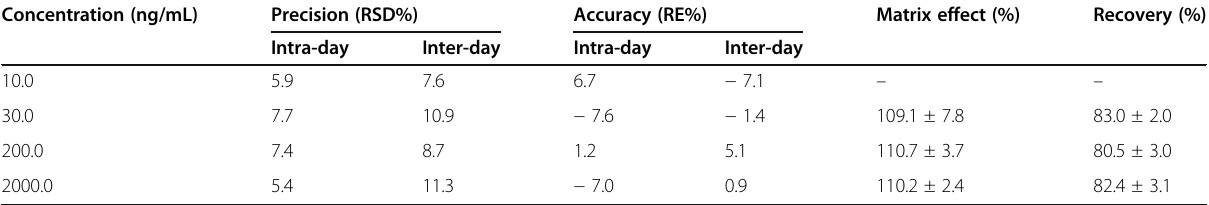
Table 1 Summary of precision, accuracy, recovery, and matrix effect for DMP in rat plasma ( n = 6) Concentration